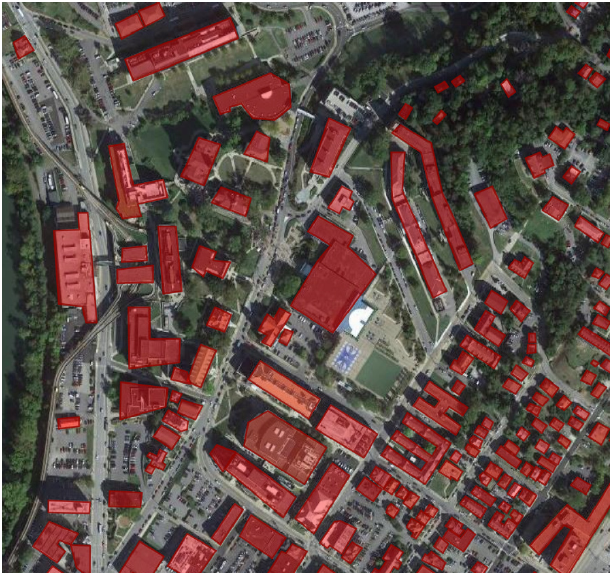
Figure 9. Map of West Virginia University (WVU) downtown campus. The red-highlighted buildings are the blockages, and the base stations and user are randomly placed over the